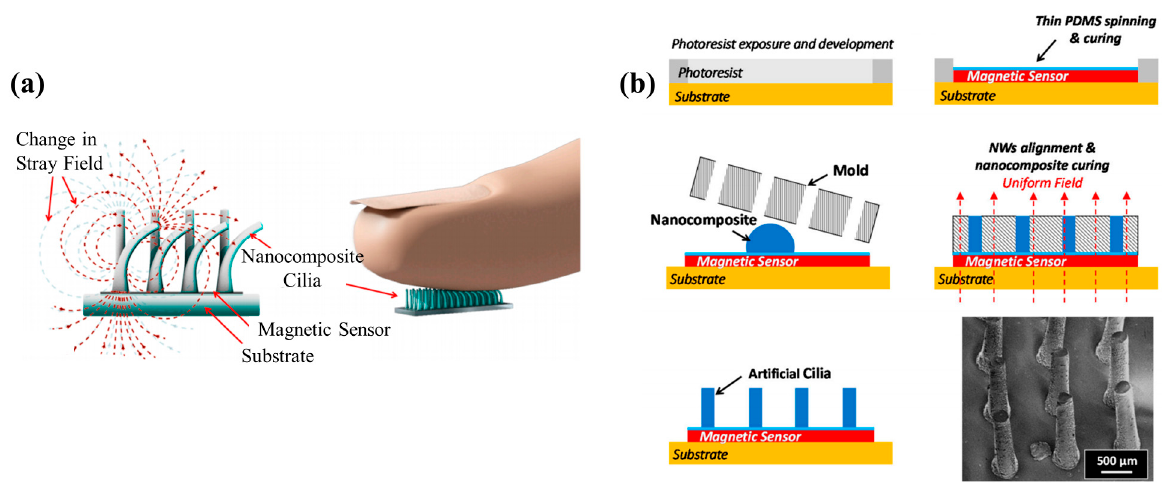
Figure 13. ( a ) Structure and working principle of the sensor with ciliary structure (designed by Alfadhel Ahmed). Reprinted with permission from Ref. [60]. Copyright 2016, MDPI; ( b ) Manufacturing process of the sensor. Reprinted with permission from Ref. [60]. Copyright 2016, MDPI.